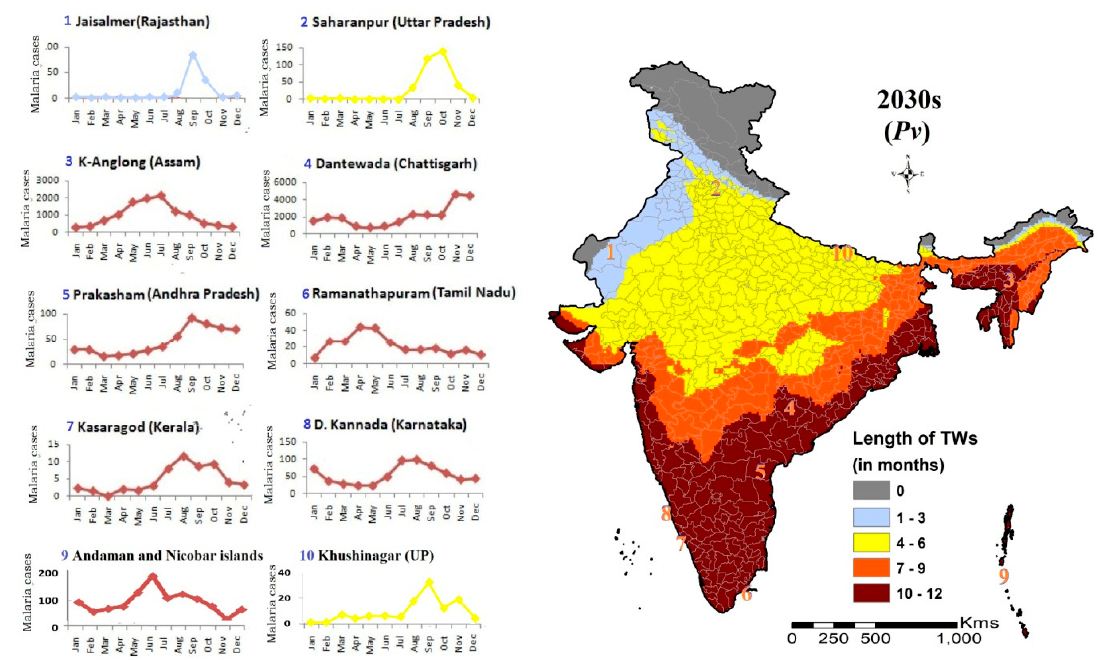
Figure 7. Climate-based Transmission Windows (TW) Vis-à-vis malaria endemicity in selected districts of India. Seasonal fluctuations in 10 representative districts match with months of TWs shown in the map in almost all the districts except Kasaragod (Kerala). In the state of Kerala, malaria transmission is very low due to various other reasons.